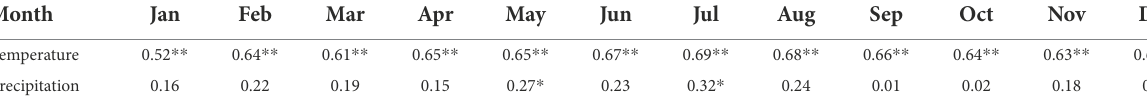
TABLE 4 Correlation coefficients between marsh AGB and monthly climatic variables.